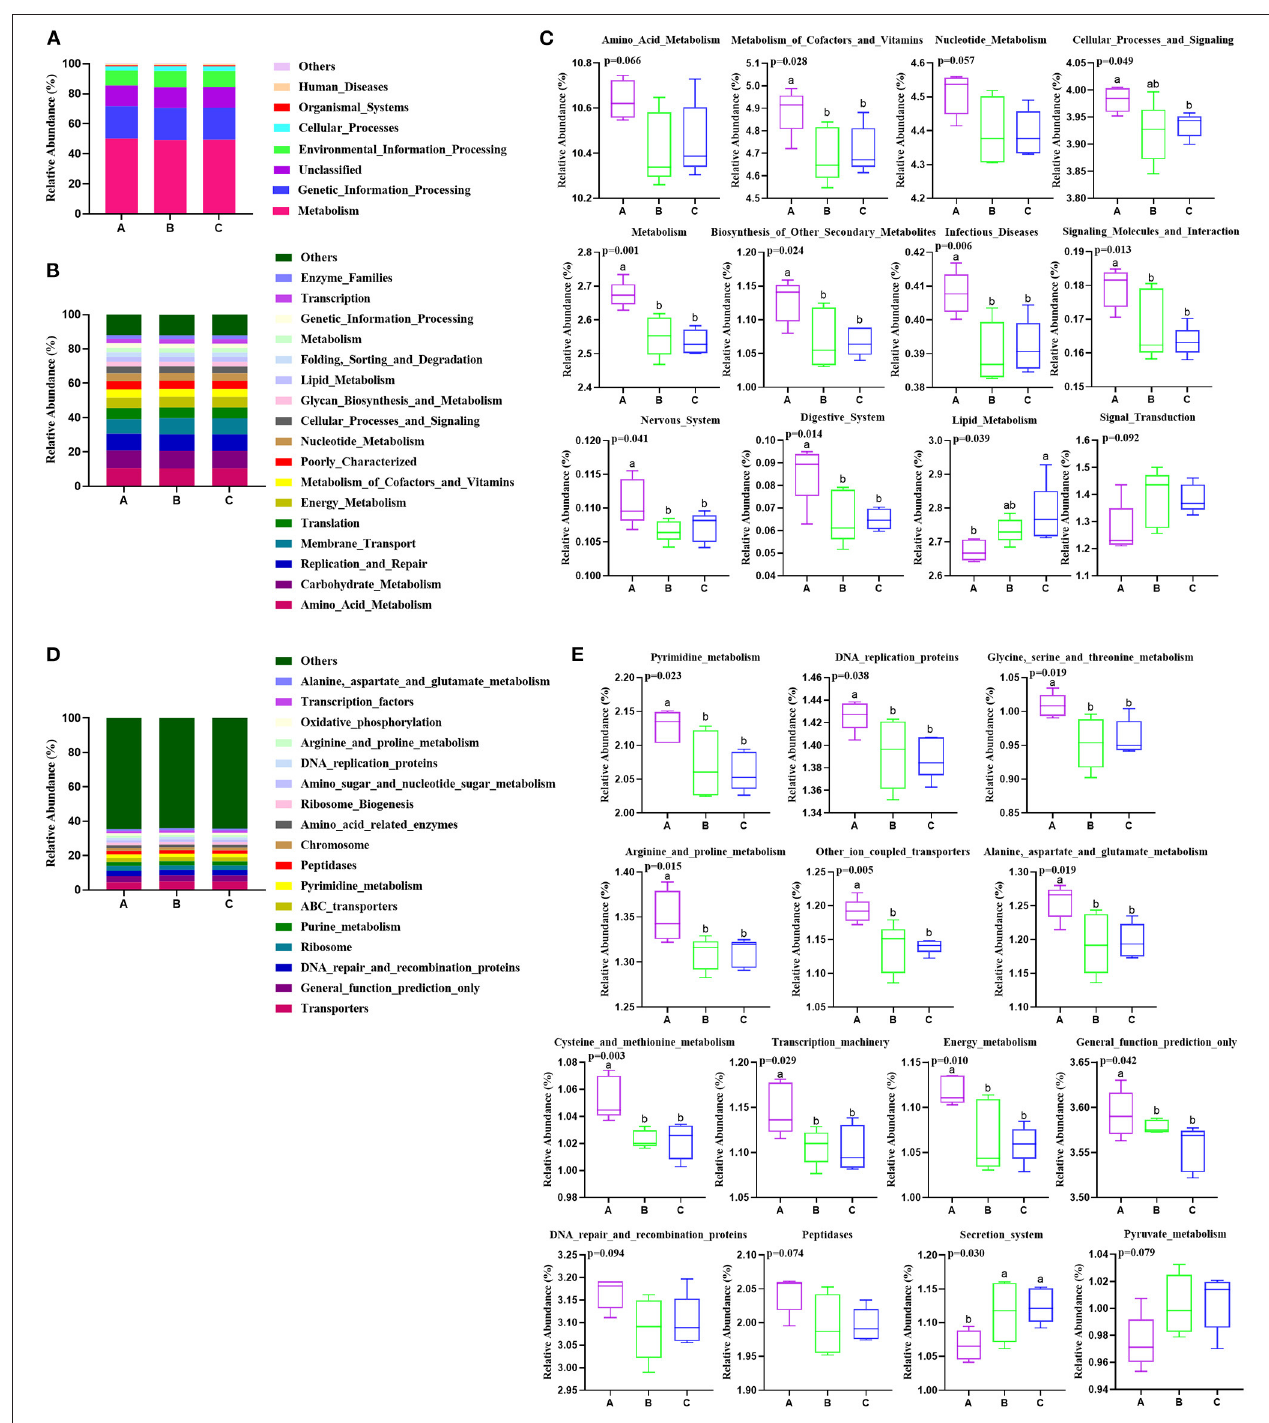
FIGURE 3 | Effects of PSR silage totally or partially substituted the corn silage on the predicted functional composition of rumen bacterial community in Angus beef cattle ( N = 5). Group A, fed 60% PSR silage; Group B, fed 30% PSR silage 30% corn silage; and Group C, fed 60% corn silage. (A) The majority of the gene sequences annotated to KEGG level 1. (B) The majority of the gene sequences annotated to KEGG level 2. (C) The gene families of significant differences at KEGG level 2. (D) The majority of the gene sequences annotated to KEGG level 3. (E) The relative abundant pathways with significant differences at KEGG level 3. Bars with different letters (a,b) indicate significant differences ( p < 0.05) among different